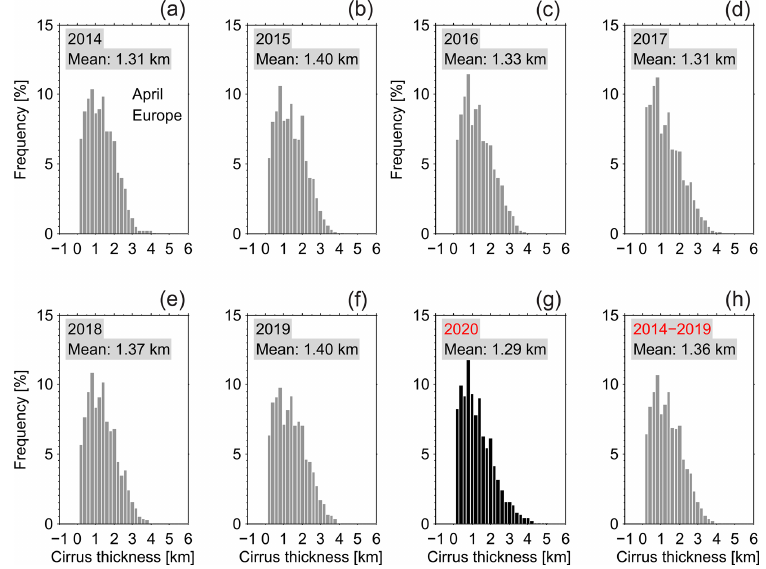
Figure 5. Same as Fig. 4 but for the geometrical thicknesses of cirrus clouds in April.